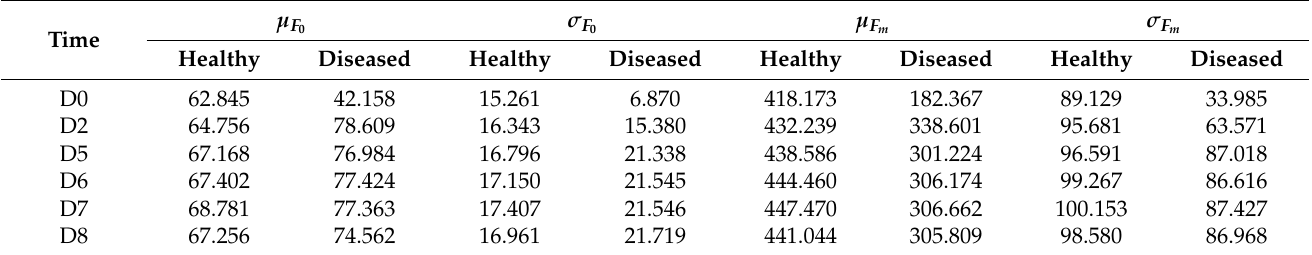
Table 2. Mean µ , and standard deviation, σ , values on Healthy and Diseased tissues of chlorophyll fluorescence parameters F 0 (minimum fluorescence) and F m (maximum fluorescence) for images of plants inoculated with bacteria. D0, ..., and D8 are the six days of the acquisition of chlorophyll fluorescence